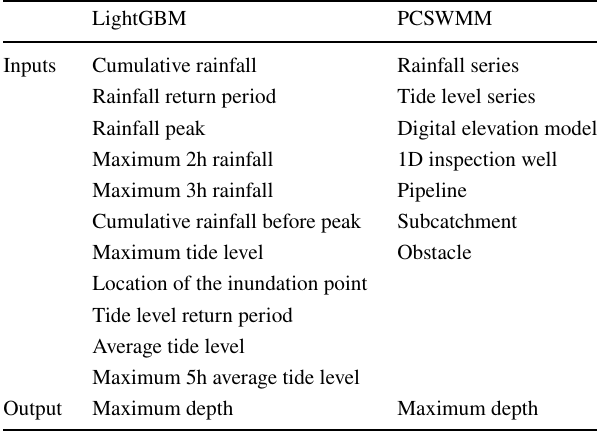
Table 3 The inputs and output of the light gradient boosting